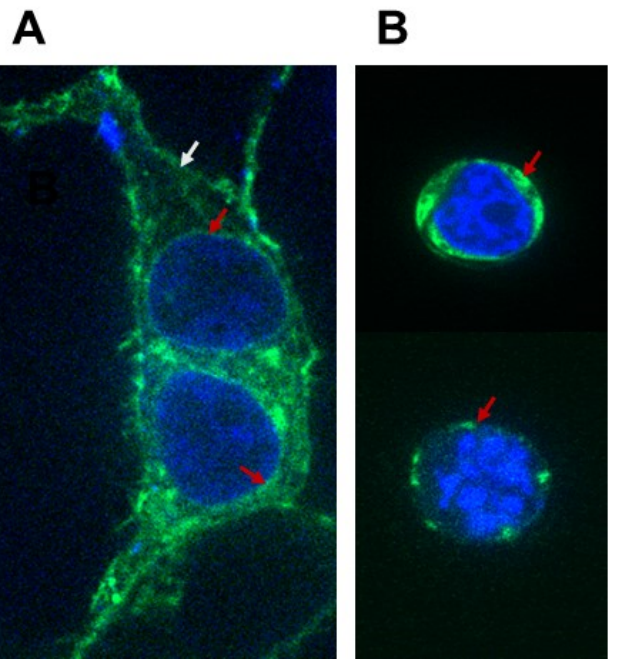
Figure 2. GPR37L1-GFP localized at the plasma and the nuclear membrane. Immunofluorescence images of whole cell and nuclei of hRPTCs showing the expression of GPR37L1-GFP at the plasma and the nuclear membrane. hRPTCs grown on glass bottom microwell dishes were transfected with the plasmid GPR37L1-GFP. Two days following transfection, the ( A ) whole cells or ( B ) nuclei pre- pared as described in the methods were fixed with 1% PFA for 10 min. Subcellular locations of GPR37L1-GFP expression were detected by fluorescence confocal microscopy at 600× magnification. GPR37L1-GFP, green; nucleus, blue. An example for the locations of the GPR37L1-GFP on the plasma membrane and nuclear membrane are indicated by the white and red arrows, respectively.